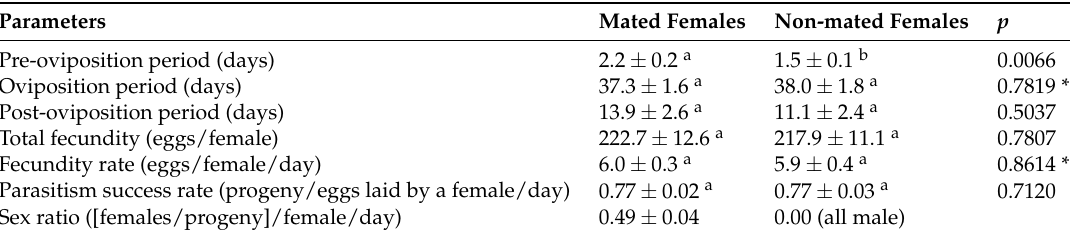
Table 1. Reproduction parameters (mean ± SE) of Ooencyrtus lucidus on Bagrada hilaris .